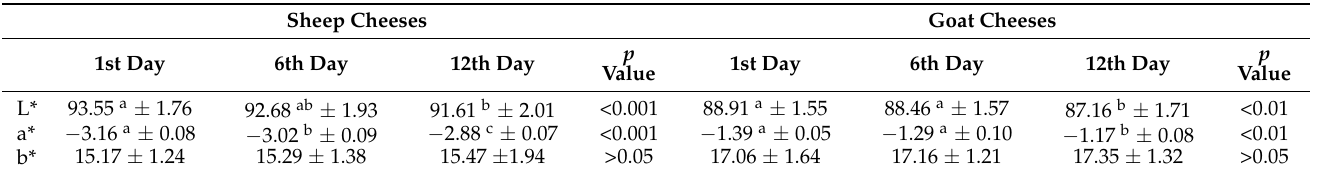
Table 7. Means and their standard deviations (mean ± SD) of color characteristics of sheep and goat cheeses at 1st, 6th, and 12th of ripening.